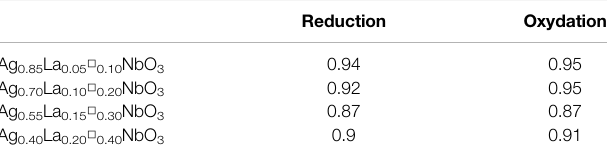
TABLE 1 | b value of Ag 1-3x La x □ 2x NbO 3 for different value of x for reduction and oxidation peaks.